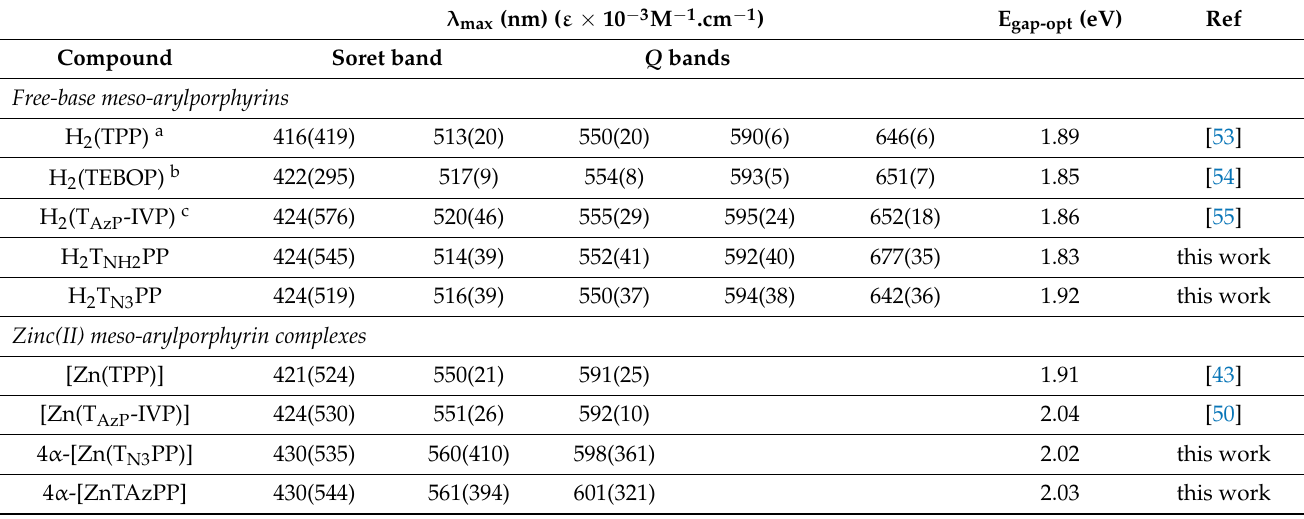
Figure 1. UV–visible spectra of compounds ( 1 )–( 4 ) recorded in dichloromethane at concentrations ~10 −6 M. The inset shows the enlarged view of the Q bands region. Table 1. UV-visible data of the free-base porphyrins and the meso -arylporphyrin zinc(II) tetracoordinated complexes. The spectra were recorded in dichloromethane.